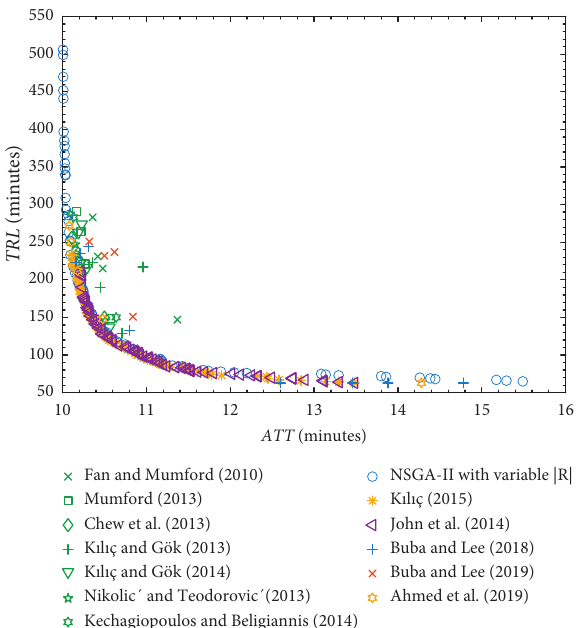
Figure 10: Comparison with previously published results for Mandl’s